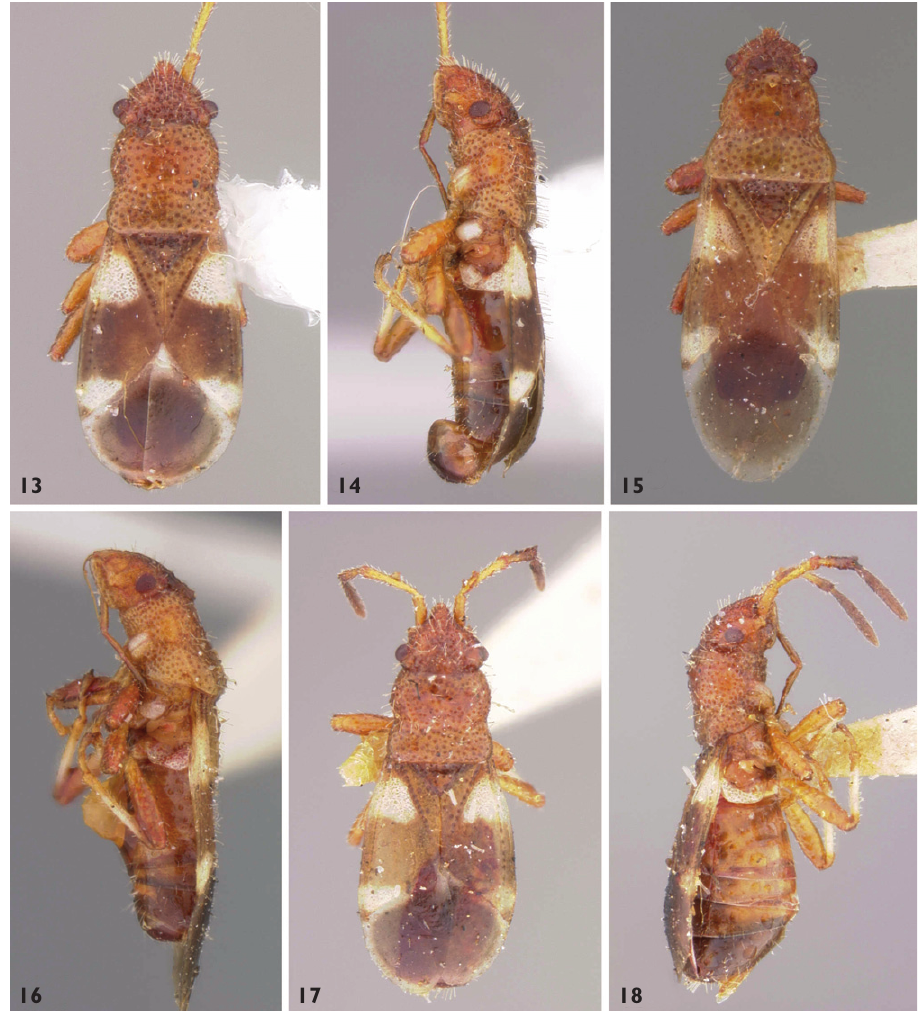
Figures 13–18. Dycoderus picturatus 13, 14 Subbrachypterous lectotype male 13 Dorsal aspect 14 Lateral aspect 15, 16 Macropterous male 15 Dorsal aspect 16 Lateral aspect 17, 18 Paralectotype female 17 Dorsal aspect 18 Lateral aspect. depressed through middle, apex weakly swollen above level of hemelytra. Hemelytron impunctate except for a few fi ne punctures on white basal third of corium. Dorsum with scattered, erect, pale setae; setae more dense on head and pronotum than on hemelytron. Total length 2.58 mm, width 0.99 mm. Head length 0.48 mm, width across eyes 0.62 mm; interocular width 0.42 mm, width between ocelli 0.32 mm. Labium: Total length 1.06 mm; segment I length 0.24 mm, II 0.26 mm, III 0.24 mm, IV 0.32 mm; extending to bases of middle coxae. Antenna: Segment I length 0.30 mm, II 0.45 mm, III 0.29 mm, IV 0.50 mm. Pronotum: Total length 0.69 mm, length of anterior